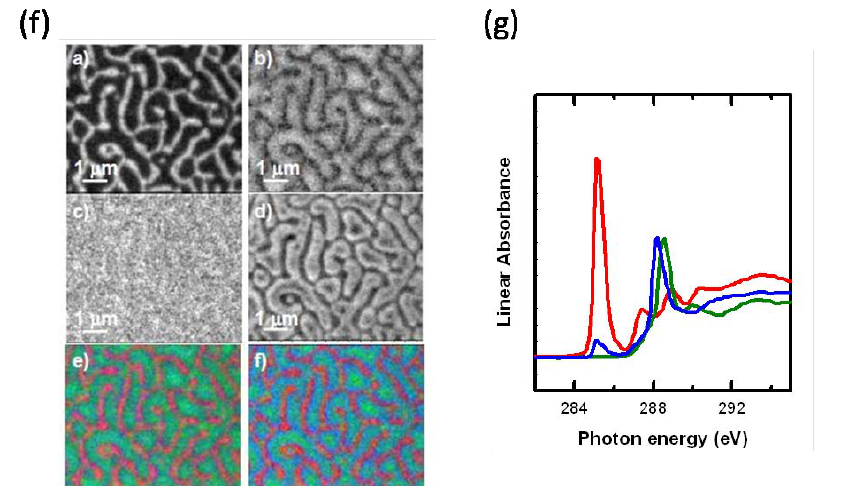
Figure 8. Component maps measured from a 40:60 PS:PLA ratio annealed 6 h at 45 ° C. Component maps of a) PS), b) PLA, c) HSA, derived from a C 1s image sequence. d) HSA component map obtained from fit to the N 1s image sequence of the same area. e) Rescaled color composite map based on component maps derived from the C 1s image sequence (red = PS, green = PLA, blue = HSA). f) Rescaled color composite map combining maps from C 1s and N 1s (red = PS (C1s), green = PLA (C1s), blue = HSA (N1s)). G) C1s NEXAFS spectra of PS (red), PLA (green) and HSA (blue). [32] (reproduced with permission of the